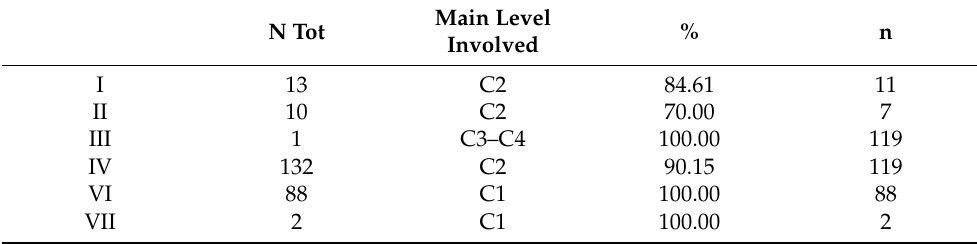
Table 2. Main cervical level that was involved for each type of mucopolysaccharidosis.